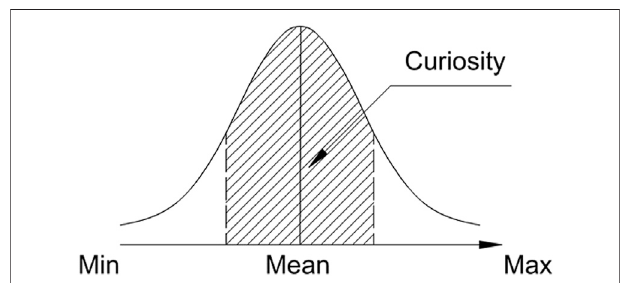
FIGURE5| Areaofthe novelty distribution,attracting curiosity inlearning new